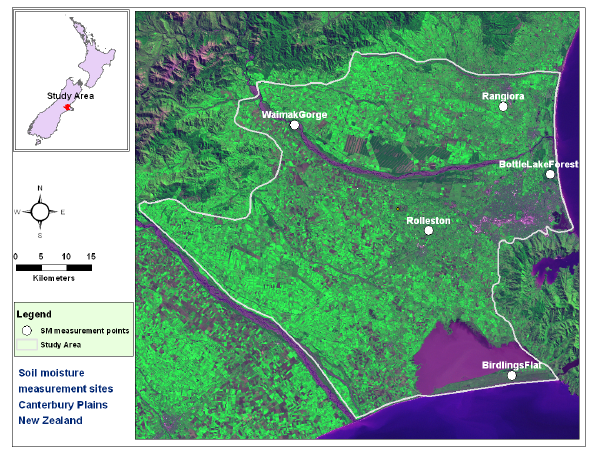
Figure 1: In-situ soil moisture measurement points overlaid on Landsat image (TM5, 28 March